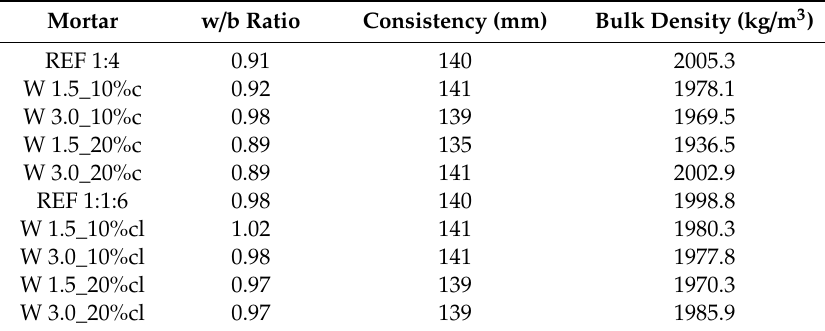
Figure 5. Dynamic modulus of elasticity of the cement mortars. Figure 6. Dynamic modulus of elasticity of the cement-lime mortars. In general, the modified mortars presented a lower modulus of elasticity when compared to the reference mortars. For cement mortars, the modulus of elasticity decreased from 28 to 180 days. This could be attributed to the internal micro-cracking of the mortars over time. The opposite trend occurred in cement-lime mortars (i.e. the modulus of elasticity presented a slight increase from 28 to 90 days). According to Araya-Letelier et al. [26], the incorporation of pig hair in mortars did not lead to a significant reduction in the dynamic modulus of elasticity. The authors explained this effect by the small amount of total fiber volume incorporated (up to 1.5%). 3.2.3. Ultra-Sound Pulse Velocity of the Hardened Mortars The ultra-sound pulse velocity test was performed at 28, 90, and 180 days. The results are presented in Table 5. The ultra-sound pulse velocity results showed that the incorporation of fibers